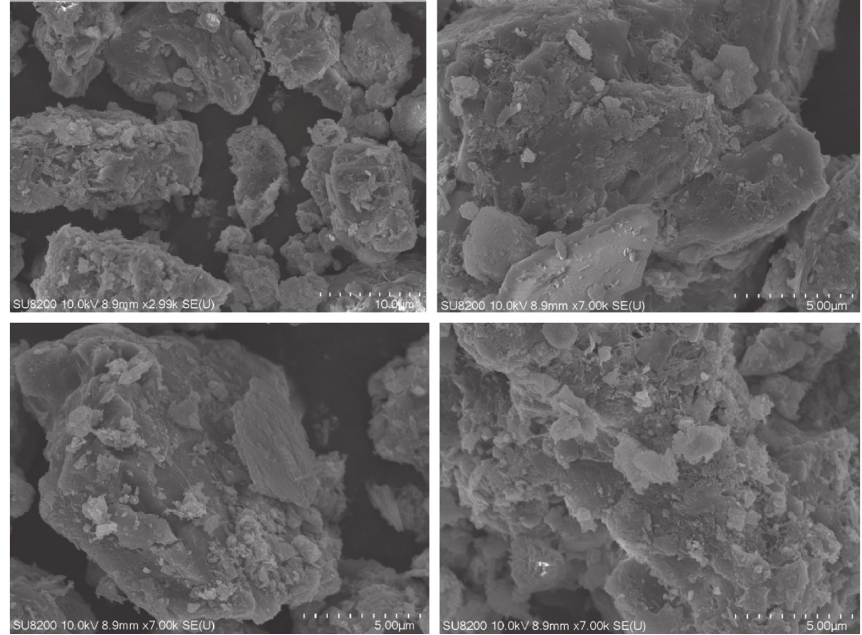
Figure 10: Microstructure of Group 3.